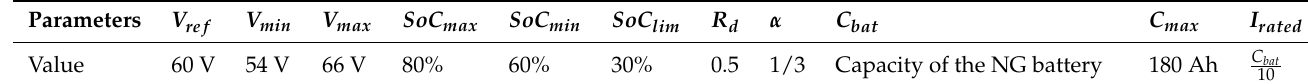
Figure 7. Decentralized and communication-free control algorithm. Table 1. Parameters of the proposed control